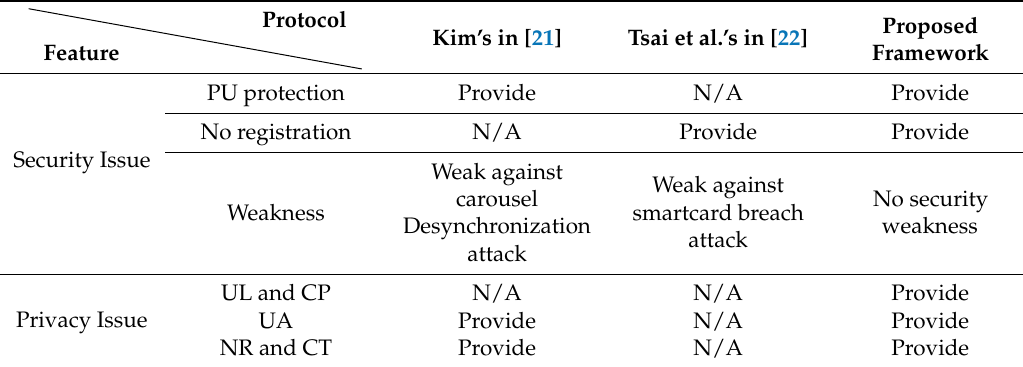
Table 4. Security and privacy feature comparison among the related